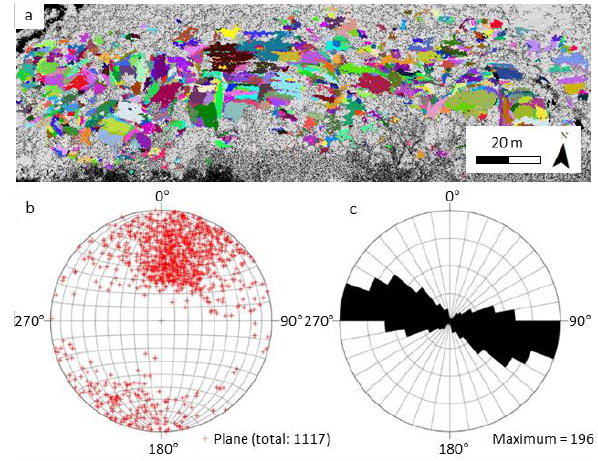
Figure 9. (a) Visualization of plane segments in area of in- terest fit into point cloud of scan position 01 (b) Equal area stereographic projection of poles to planes (c) Rose plot of strike directions